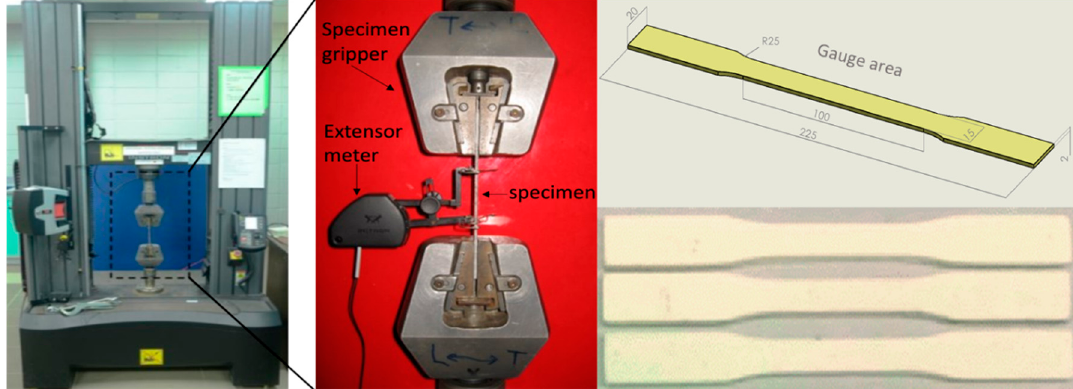
Figure 2. Tensile testing machine and tensile test samples to extract the material properties of resin pins.